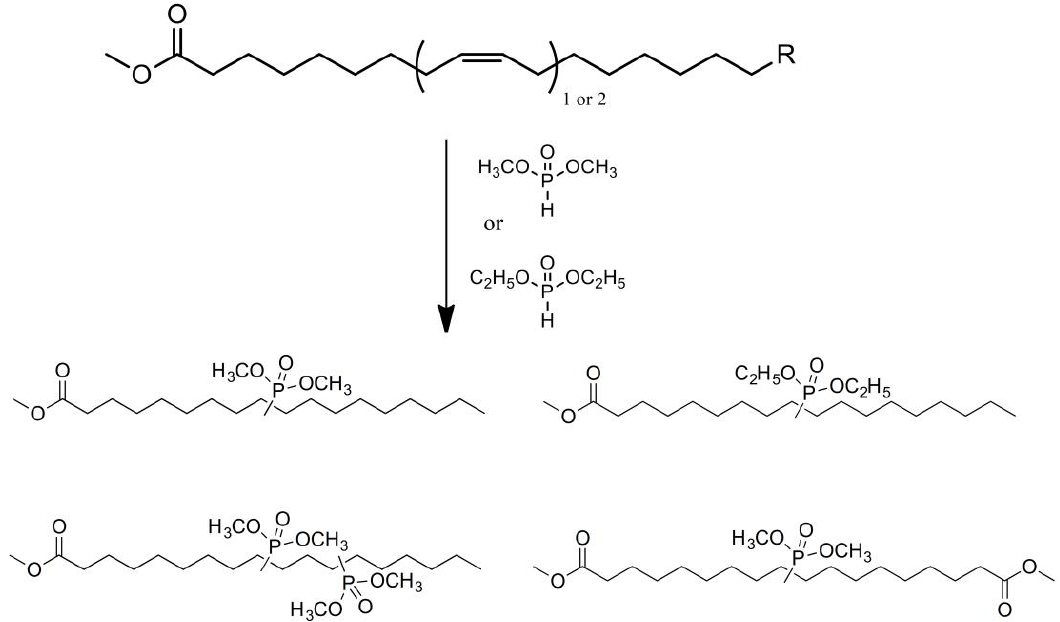
Figure 18. Synthesis of phosphonate groups containing bio-based plasticizers. Table 1 Flame-retardant elements (phosphate, chlorine and nitrogen) containing vegetable oil-based plasticizers.